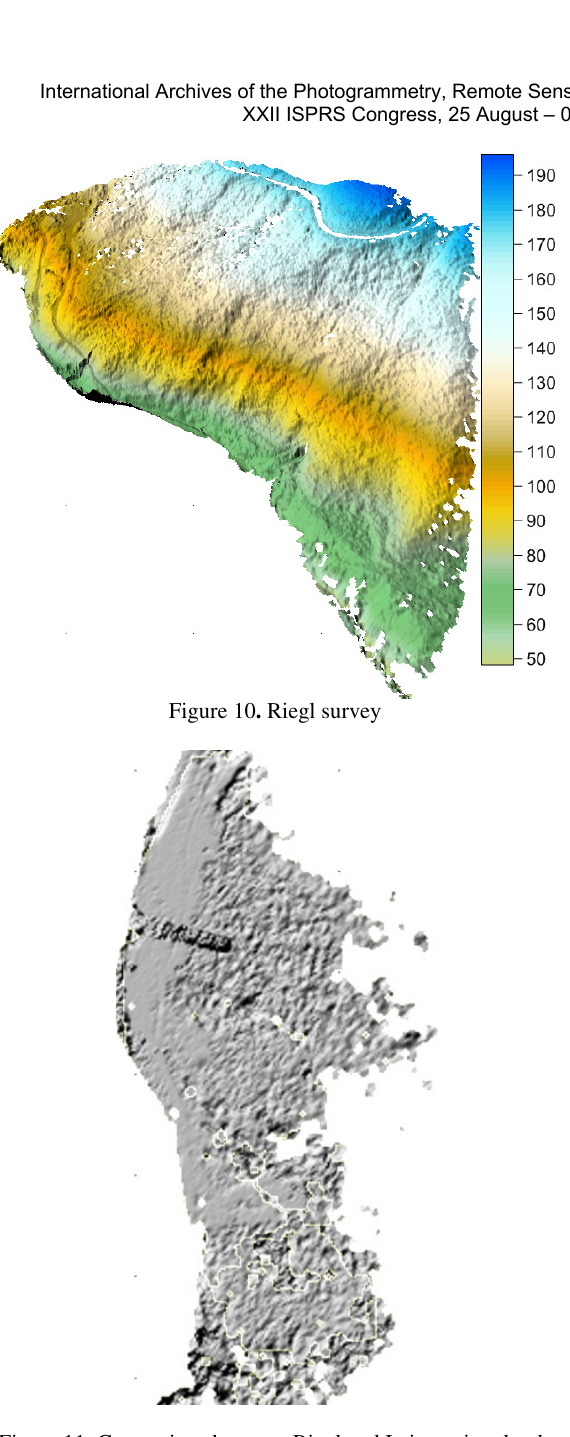
Figure 11. Comparison between Riegl and Leica